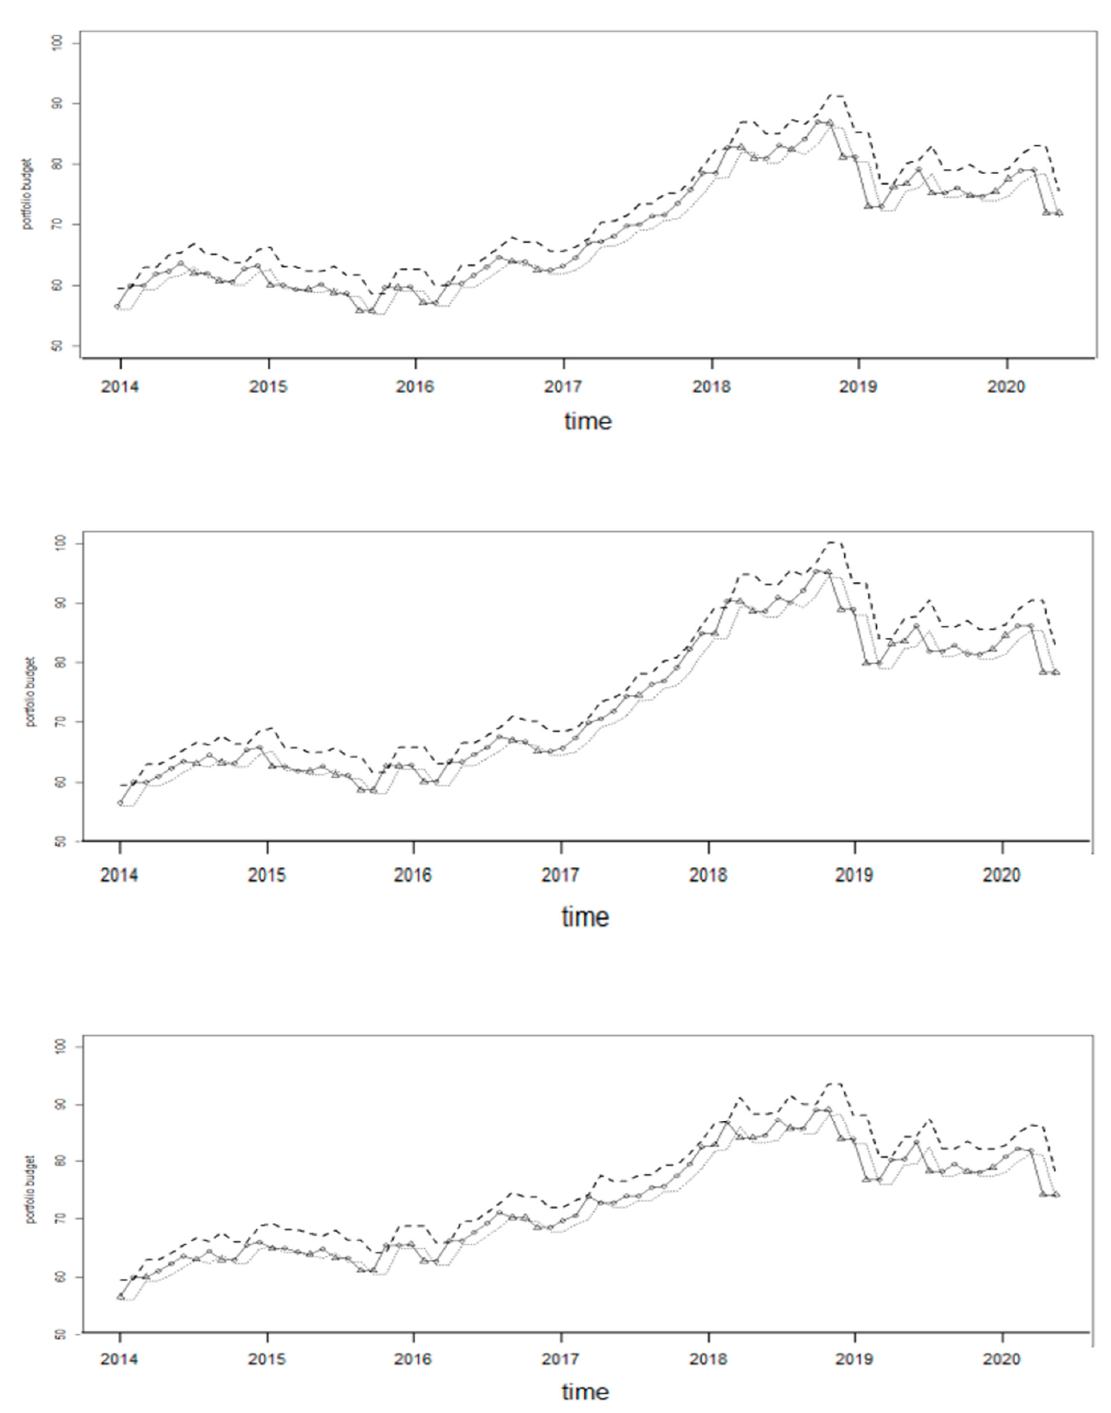
Figure 6. The solid line shows the true value of the portfolio budget while upper and lower bounds are computed as 5% and 1% of the portfolio budget at time t. Upper panel α = 0.1, middle panel α = 0.5, and bottom panel α = 0.9. Source: our